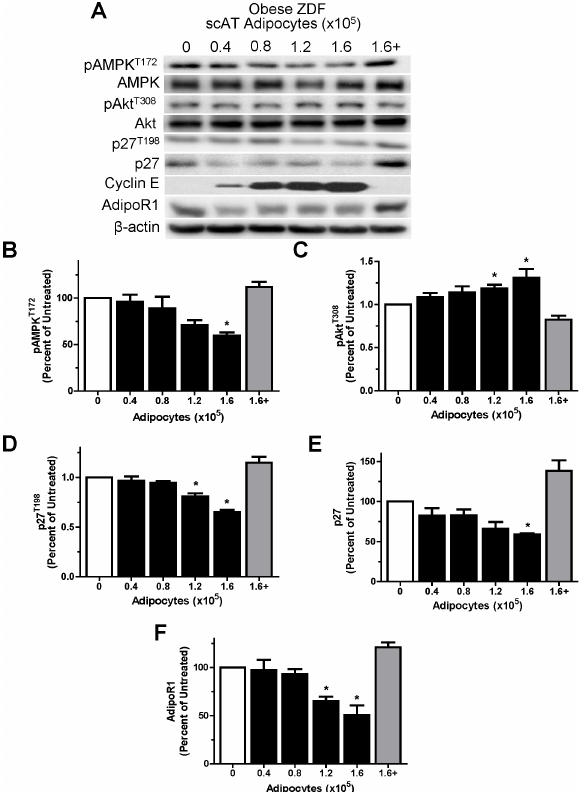
Fig 3. ZDF subcutaneous adipocytes co-culture negatively affects MCF7 cell cycle proteins in does- dependent manner. A: Representative western blots for selectedproteins showingthe effects of treatment with UT (open bar) or ZDF scAT increasing adipocytenumber (closedbars) or the highest adipocytenumber (1.6 × 10 5 ) plus ADIPO (18 nM; grey bar) co-culture treatment for 24 hours in arrested MCF7 cells. B-F: Graphicalrepresentations of multipleexperiments showingthe effects of ZDF scAT increasingadipocyte numberand the additionof ADIPO (18 nM) on pAMPK T172 , pAKT T308 , p27, p27 T198 and AdipoR1protein levels. β -actin was used as a loadingcontrol. One-way ANOVAs showedsignificantmain effects for all experiments (p < 0.05). * denotessignificantly different from ZDF (p < 0.05)as determined by Tukey’s post-hoc tests (n =